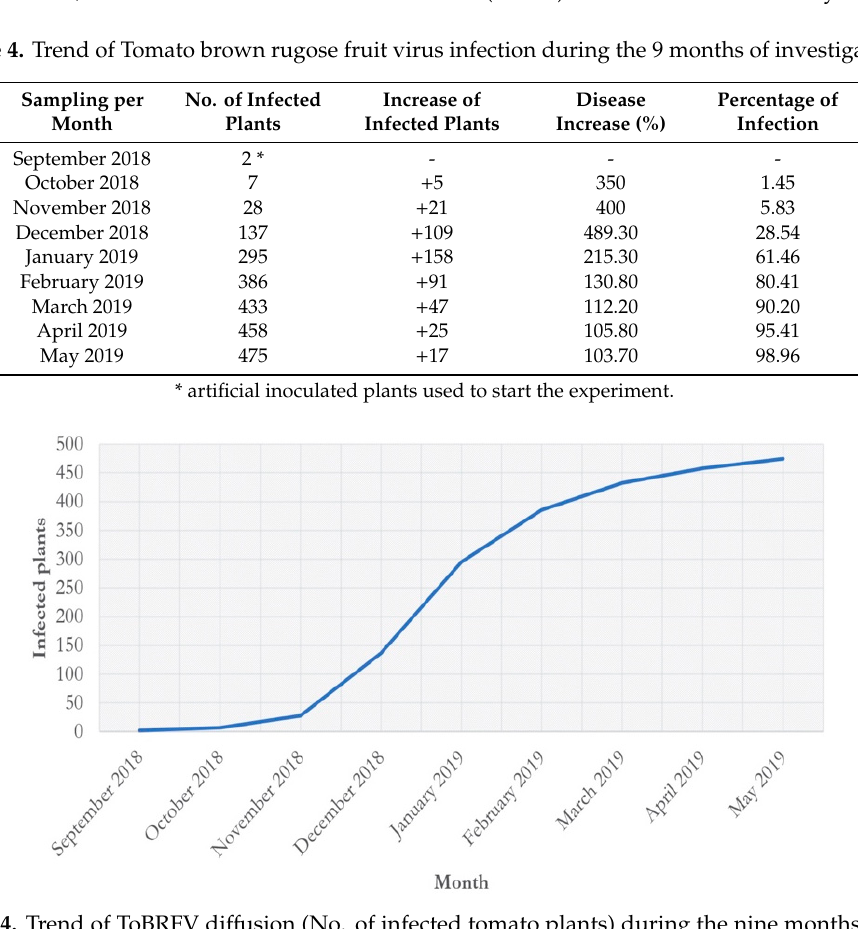
Figure 3. Number of tomato greenhouses inspected per month, during the period October 2018– January 2020 and percentage of ToBRFV-infected greenhouses.